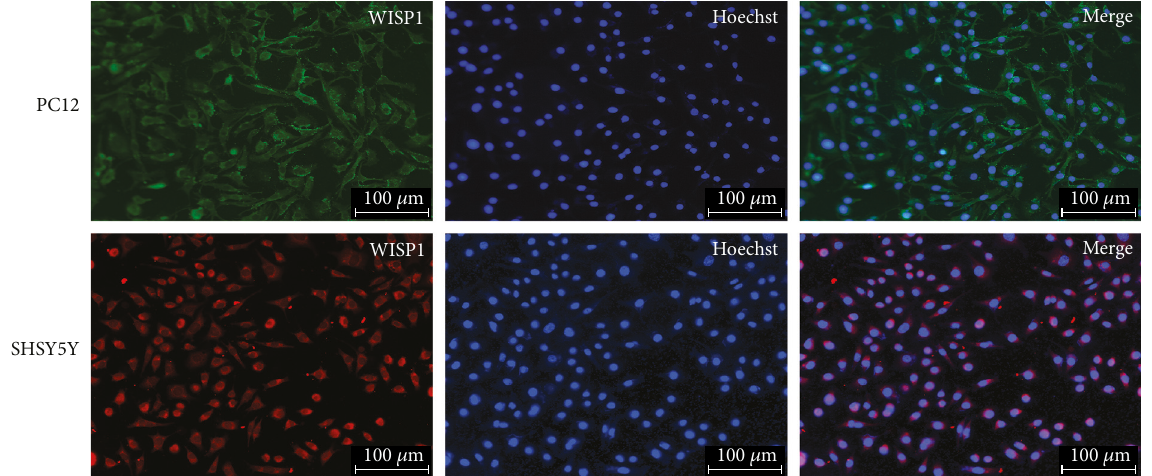
Figure 10: Immuno fl uorescence of WISP1 in SHSY5Y with PC12 cells. Red or green: WISP1; blue: Hoechst; bar =100 μ